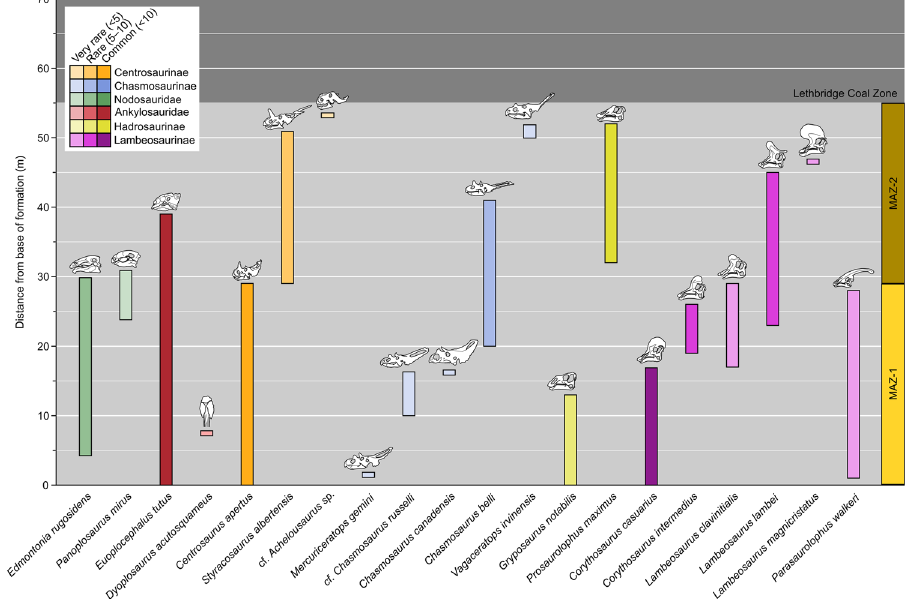
Figure 3. Biostratigraphy of megaherbivores from the Dinosaur Park Formation, in the area of Dinosaur Provincial Park, Alberta. Note that stratigraphic overlap between members of the same family (in the case of ankylosaurs) or subfamily (in the case of ceratopsids and hadrosaurids) is limited, only involving examples of rare or short-lived species. Abbreviations: MAZ, Megaherbivore Assemblage Zone. Modified from Mallon et al . 29